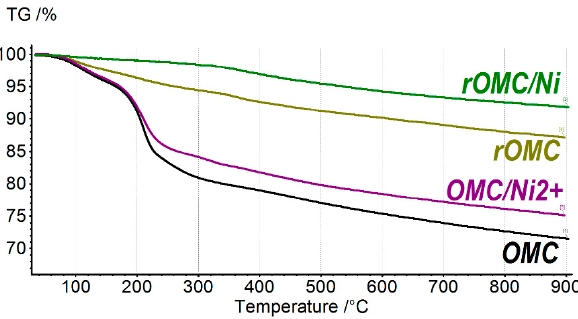
Figure 1. TGA curves for OMC, OMC/Ni 2+ , r OMC/Ni, and r OMC samples. According to the TGA data, the as-prepared OMC has a decomposition TGA curve, similar to that for GO. The sample has a weight loss of ~2% up to 120 °C, which is related mostly to the loss of adsorbed water. The main weight loss of 19.2% is in the range of 180– 300 °C. This is the characteristic weight loss of GO, associated with the decomposition of major oxygen-containing groups, such as epoxy and hydroxyl groups. The similar GO decomposition behavior suggests similar chemical composition. The residual weight is